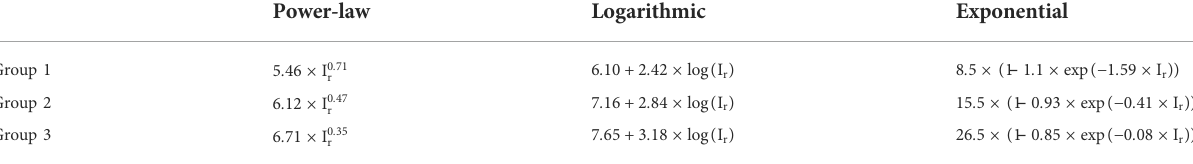
TABLE 5 KE con – I r equations corresponding to the three different rainfall event